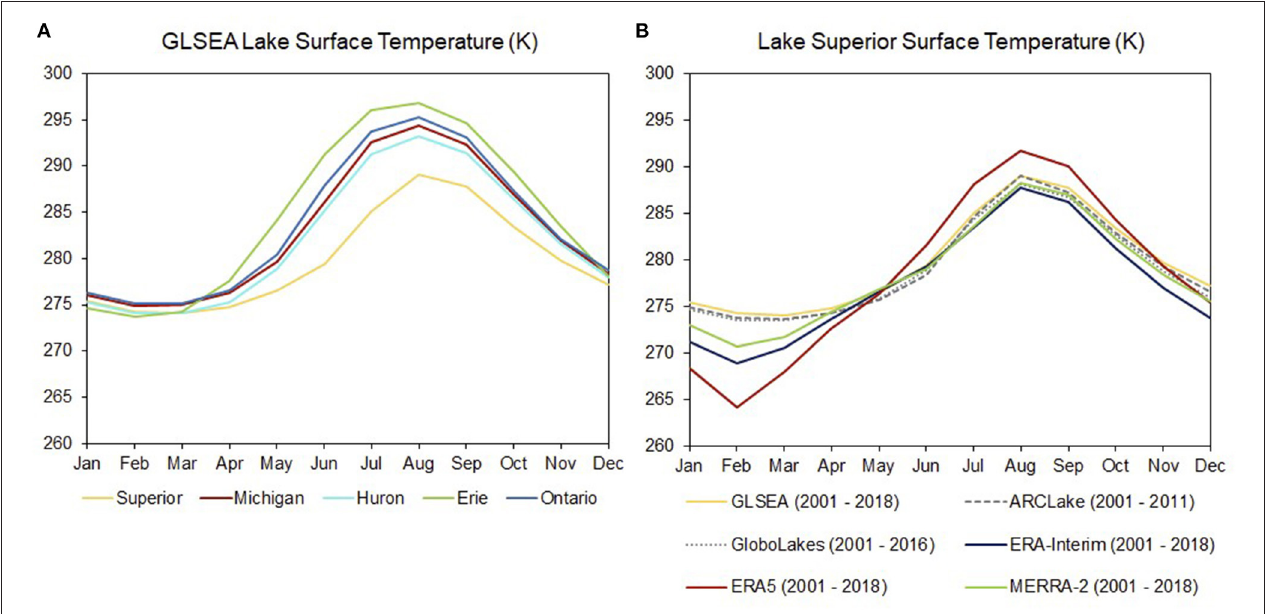
FIGURE 9 | 2001–2018 climatology of lake-average GLSEA LSWT for the five Laurentian Great Lakes (A) and Lake Superior LSWT for the different satellite-based and reanalysis datasets [ (B) ; averaging period included in the legend]. (B) Is adapted from Minallah and Steiner (2021c).